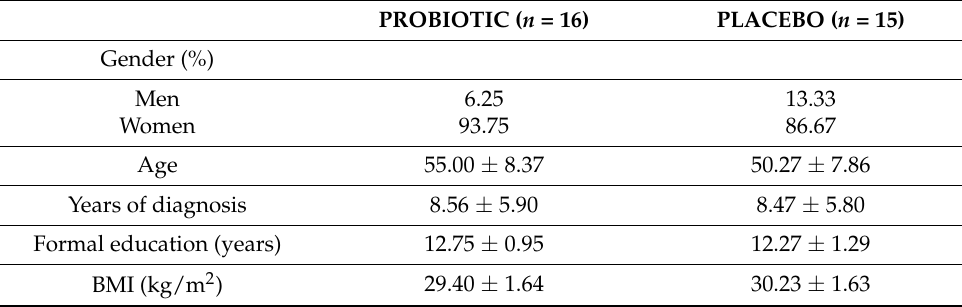
Table 1. Sociodemographic characteristics of study